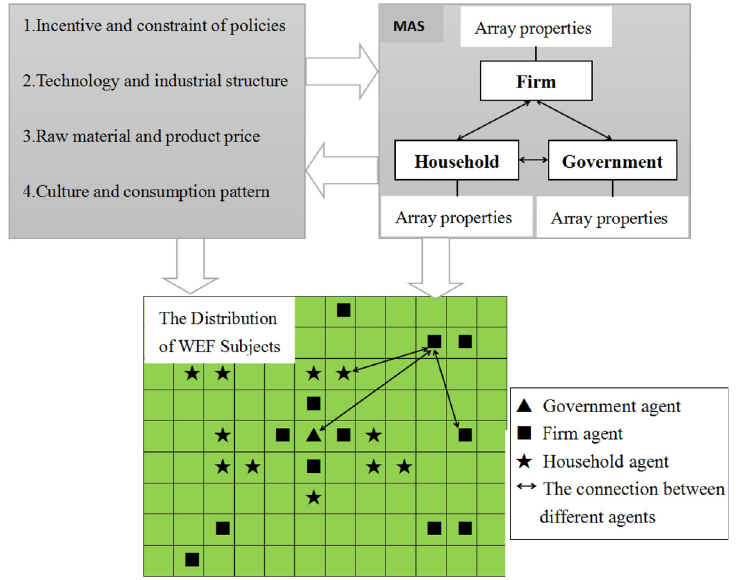
Figure 3. NetLogo simulation model for urban WEF